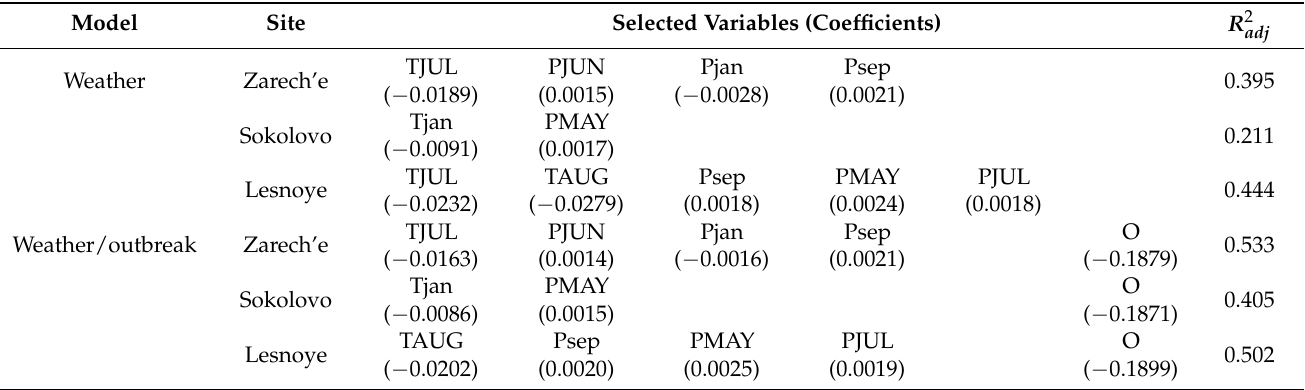
Table 6. Results of linear modeling of tree-ring width indices. Results of linear modeling of tree-ring width indices. T is the mean temperature, and P is a monthly sum of precipitation. Lowercase month abbreviations represent previous year correlations with the weather, while uppercase represents the current